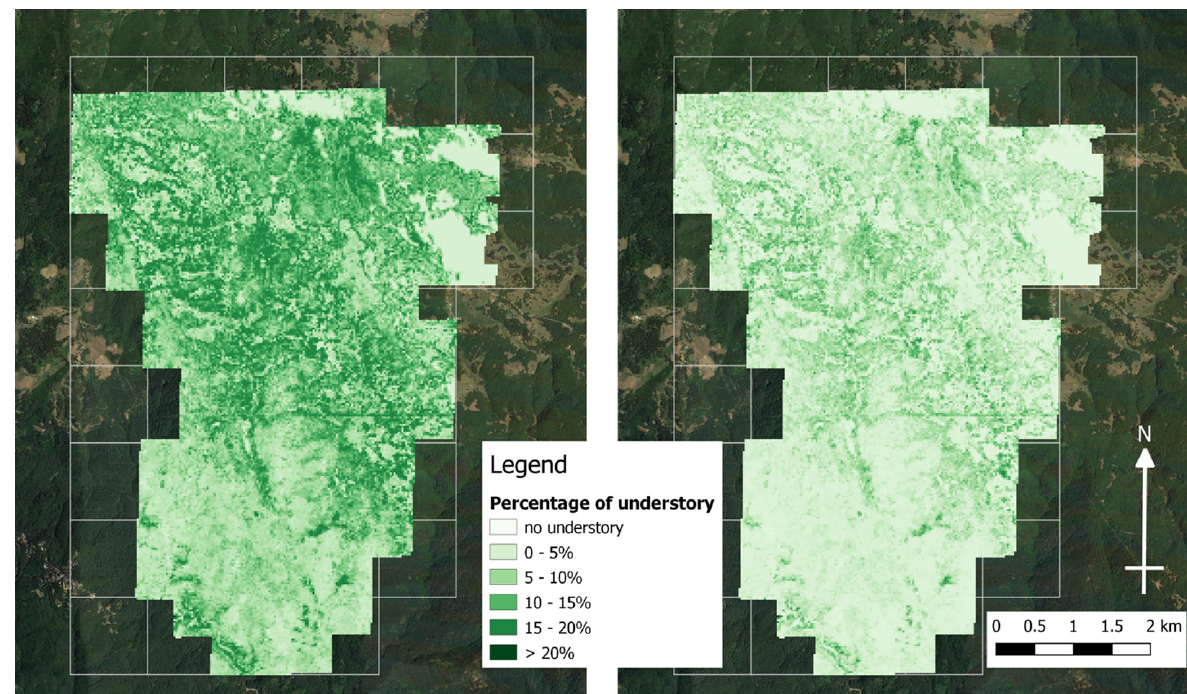
Figure 6. Lower (LU, on the left) and upper understory (UU, right) spatial prediction based on the regression models for the entire study area.